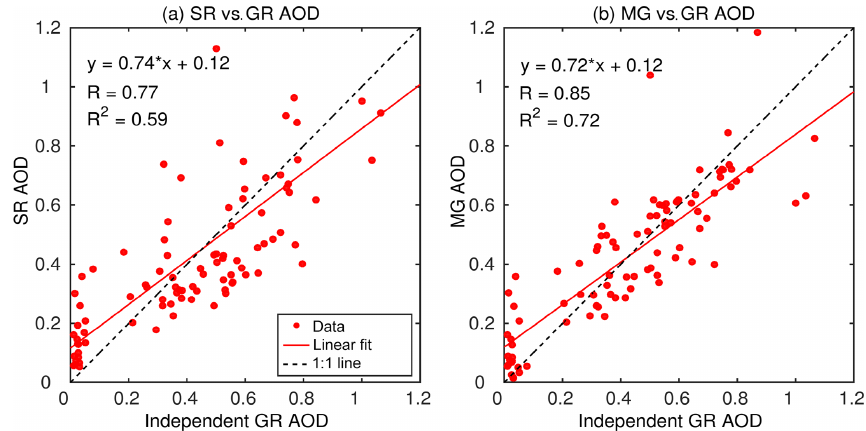
Figure 4. Validation of merged AOD product: (a) satellite AOD vs. GR AOD; (b) merged AOD vs. GR AOD. Red lines are regression fitted to the point, while the dotted black lines represent the ideal 1 : 1 case.